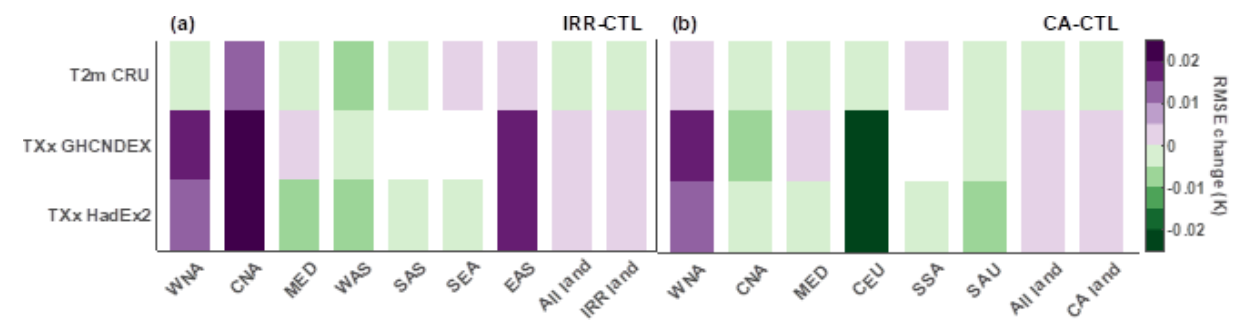
Figure 2. Added value of including irrigation and CA in the simulated warming trends over 1981–2010. Absolute change in spatial root- mean-square error (RMSE) for the (a) IRR and (b) CA ensemble relative to the CTL ensemble over different regions ( x axis) and with respect to three observational products ( y axis). Considered regions are the SREX regions where irrigation is extensive (as highlighted in Fig. 1a) and where CA is extensive (Fig. 1b), in addition to global land, global irrigated land and global CA land. Observational products are for near-surface air temperature T 2 m (CRU) and annual maximum daytime temperature TXx (GHCNDEX and HadEX2). The spatial RMSEs are computed for the ensemble mean warming trend in every pixel and subsequently averaged over the selected region. Regions with an observational coverage below 50% are marked in